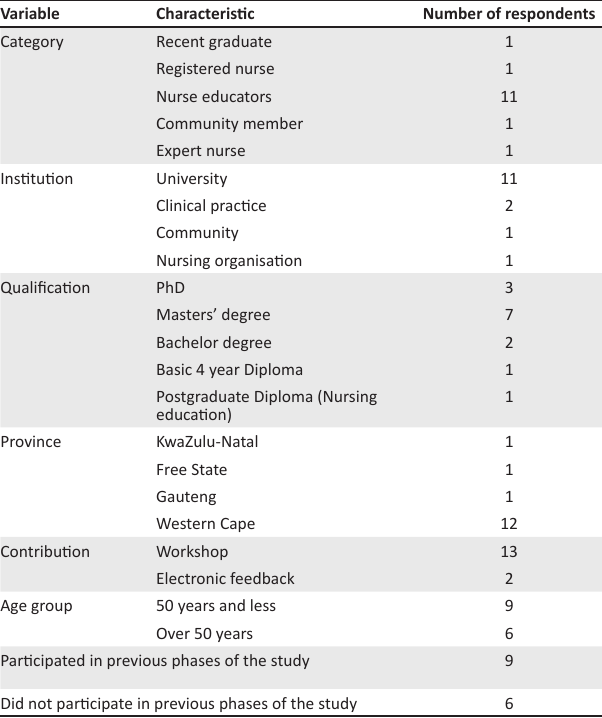
TABLE 1: Characteristics of participants – N =